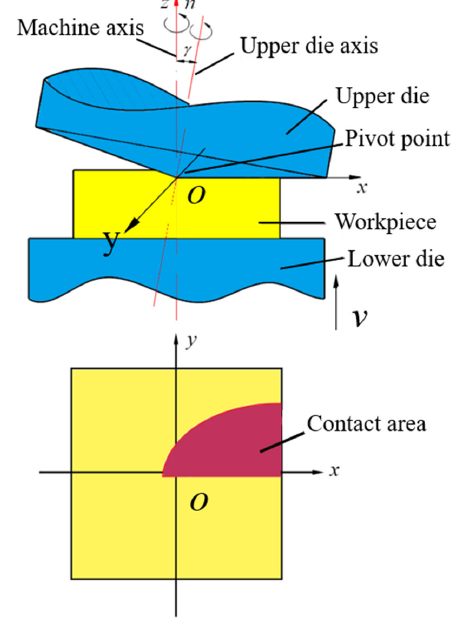
Figure 1. Principle of cold rotary forging.